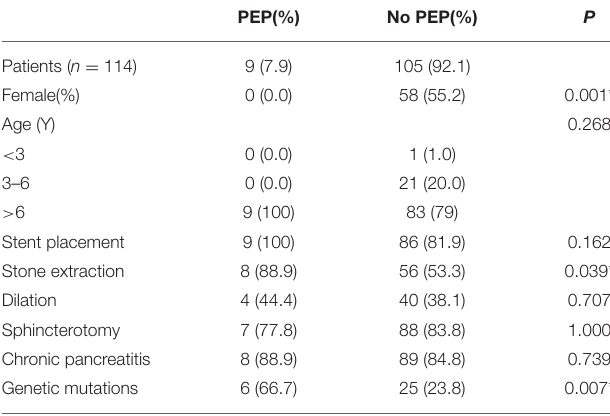
TABLE 2 | Therapeutic details of 114 procedures in 46 pediatric patients with pancreas divisum.